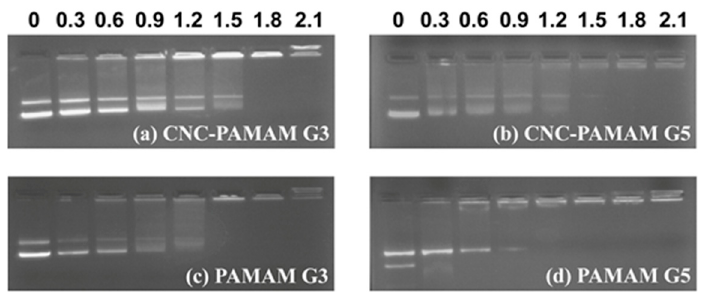
Figure 6. Electrophoretic mobility of pDNA with ( a ) CNC-PAMAM G3, ( b ) CNC-PAMAM G5, ( c ) PAMAM G3, and ( d ) PAMAM G5 at various N/P ratios.